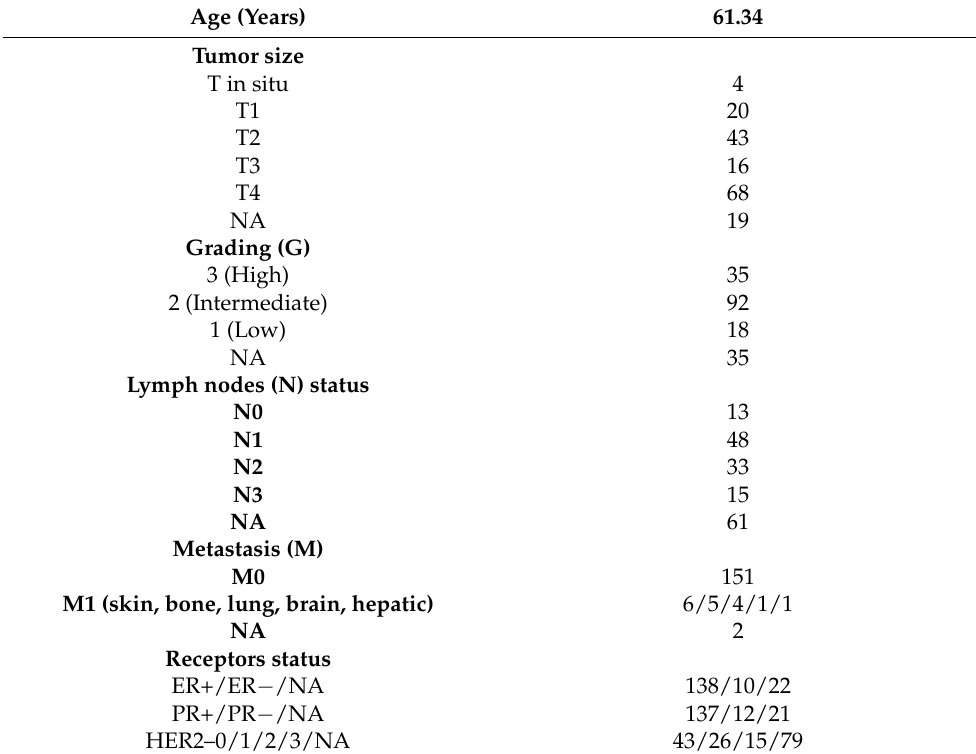
Table 1. Characteristics of male patients with breast cancer in IOCN